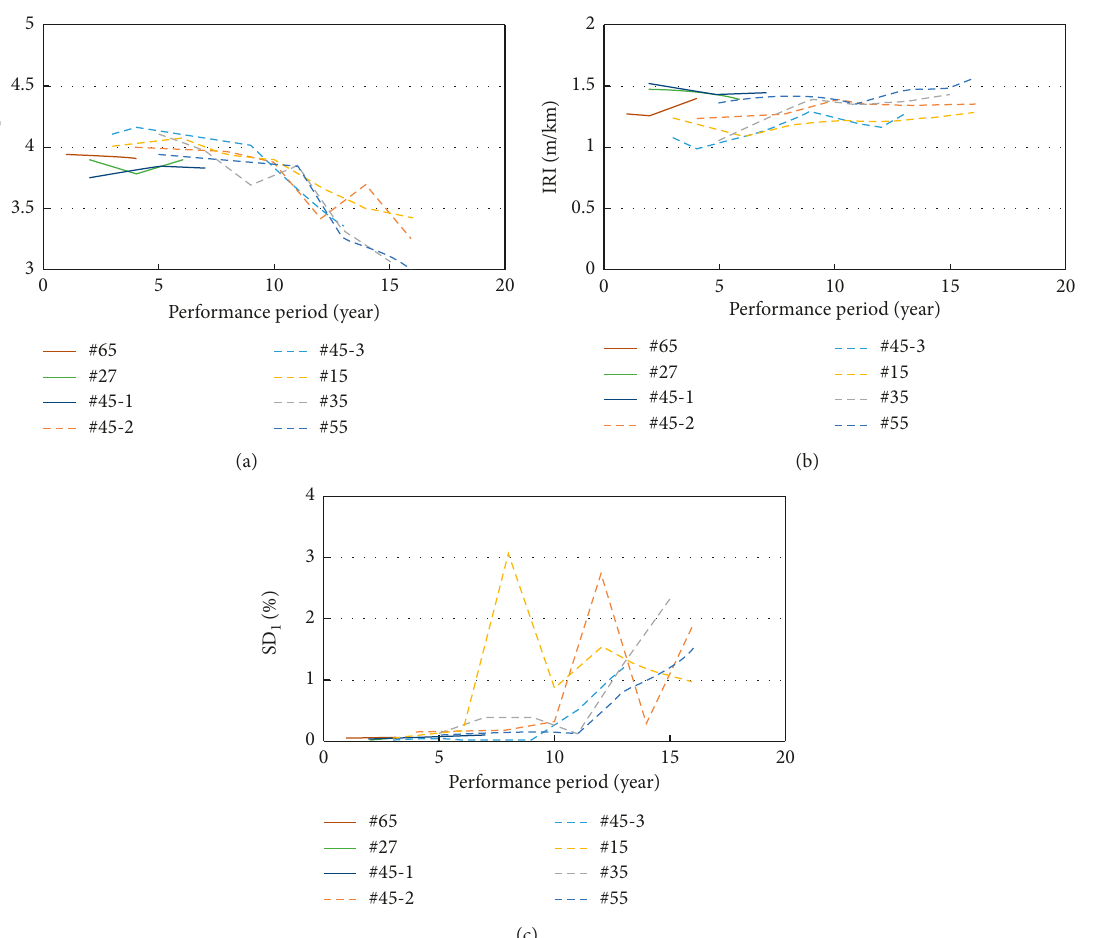
Figure 2: Pavement condition change according to the whole performance period. (a) HPCI